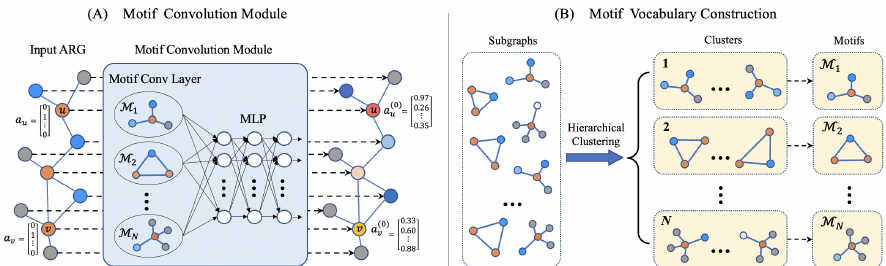
Figure 1. Motif convolution module. ( A ) The convolution operation calculates the structural similarity score between every of the N motifs and the subgraph centering at each node in the input graph (see Sections 2.2 and 2.3) to produce an N -dimension context-aware representation for the corresponding node, which is further transformed by a multilayer perceptron (MLP) network to produce a MCM- embedding for the input node. For example, although two input nodes, u and v , represent the same ( 0 ) ( 0 ) element (e.g., atom), their MCM-embeddings a u and a v are different as u and v are in different local context. An expanded illustration of MCM is shown in Figure 2. The output of MCM can be fed into GNNs. ( B ) The motif vocabulary is built via clustering on subgraphs sampled from input graphs (Section